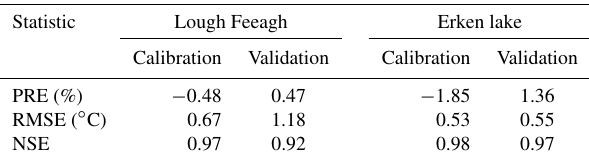
Table 1. Lake model performance evaluation, showing the percent- age relative error (%), root mean squared error ( ◦ C), and Nash– Sutcliffe efficiency for Lough Feeagh (profiles = 1016, years = 5) and Erken lake (profiles = 1449, years =